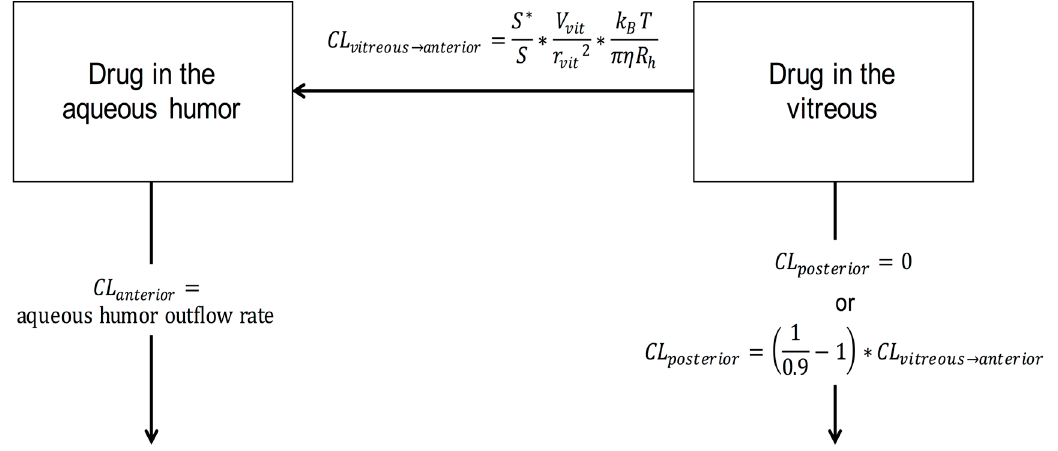
Figure 1. Schematic illustration of the simulation model.